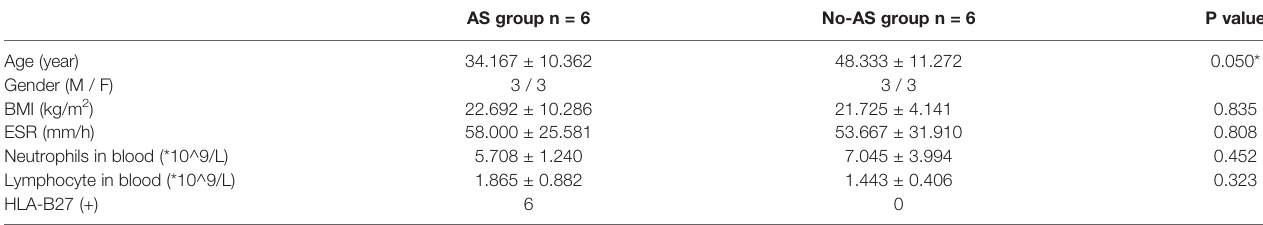
TABLE 1 | Clinical information of patients of the two groups.